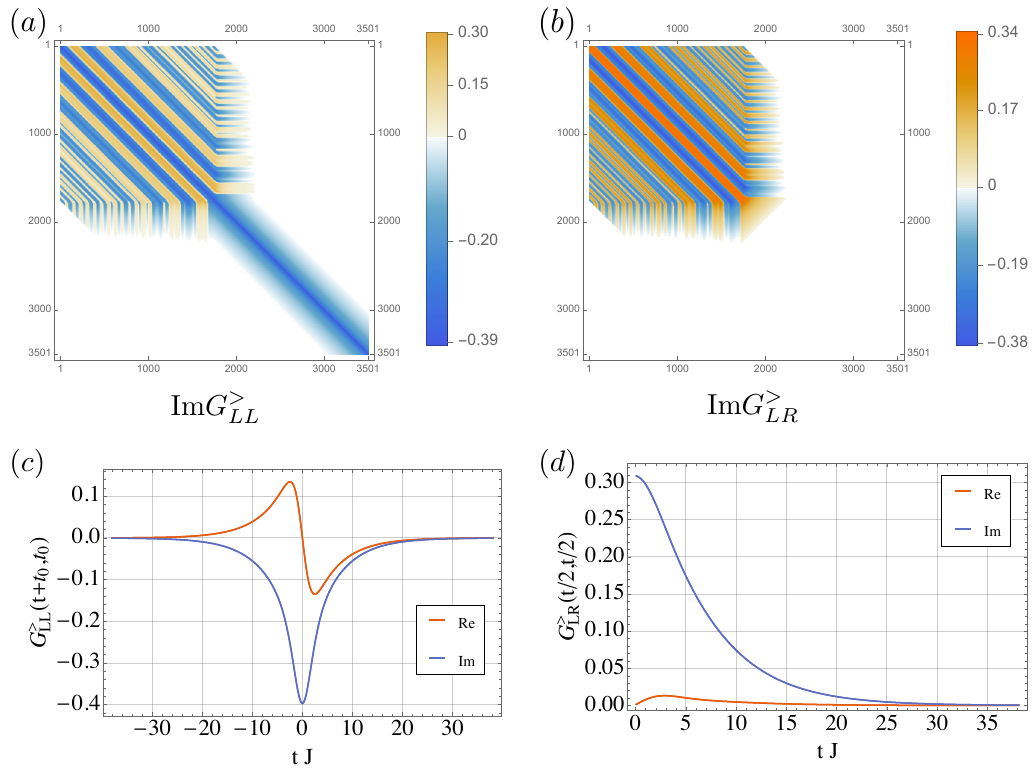
Figure 5 . The quench dynamics when turning off µ c with βJ = 40 , µ c /J = 0 . 075 and ¯ µ/J = 0 . We plot Im G > ( u 1 , u 2 ) in (a) and Im G > LL only depends on u 1 − u 2 , while G > and G > ( t/ 2 , t/ 2) explicitly in (c) and LR